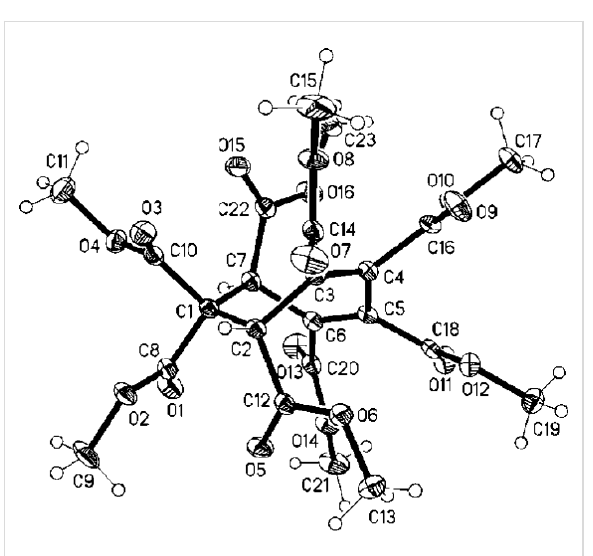
Figure 2: Structure of 24 in the crystal; ellipsoids represent 30% prob- ability levels.